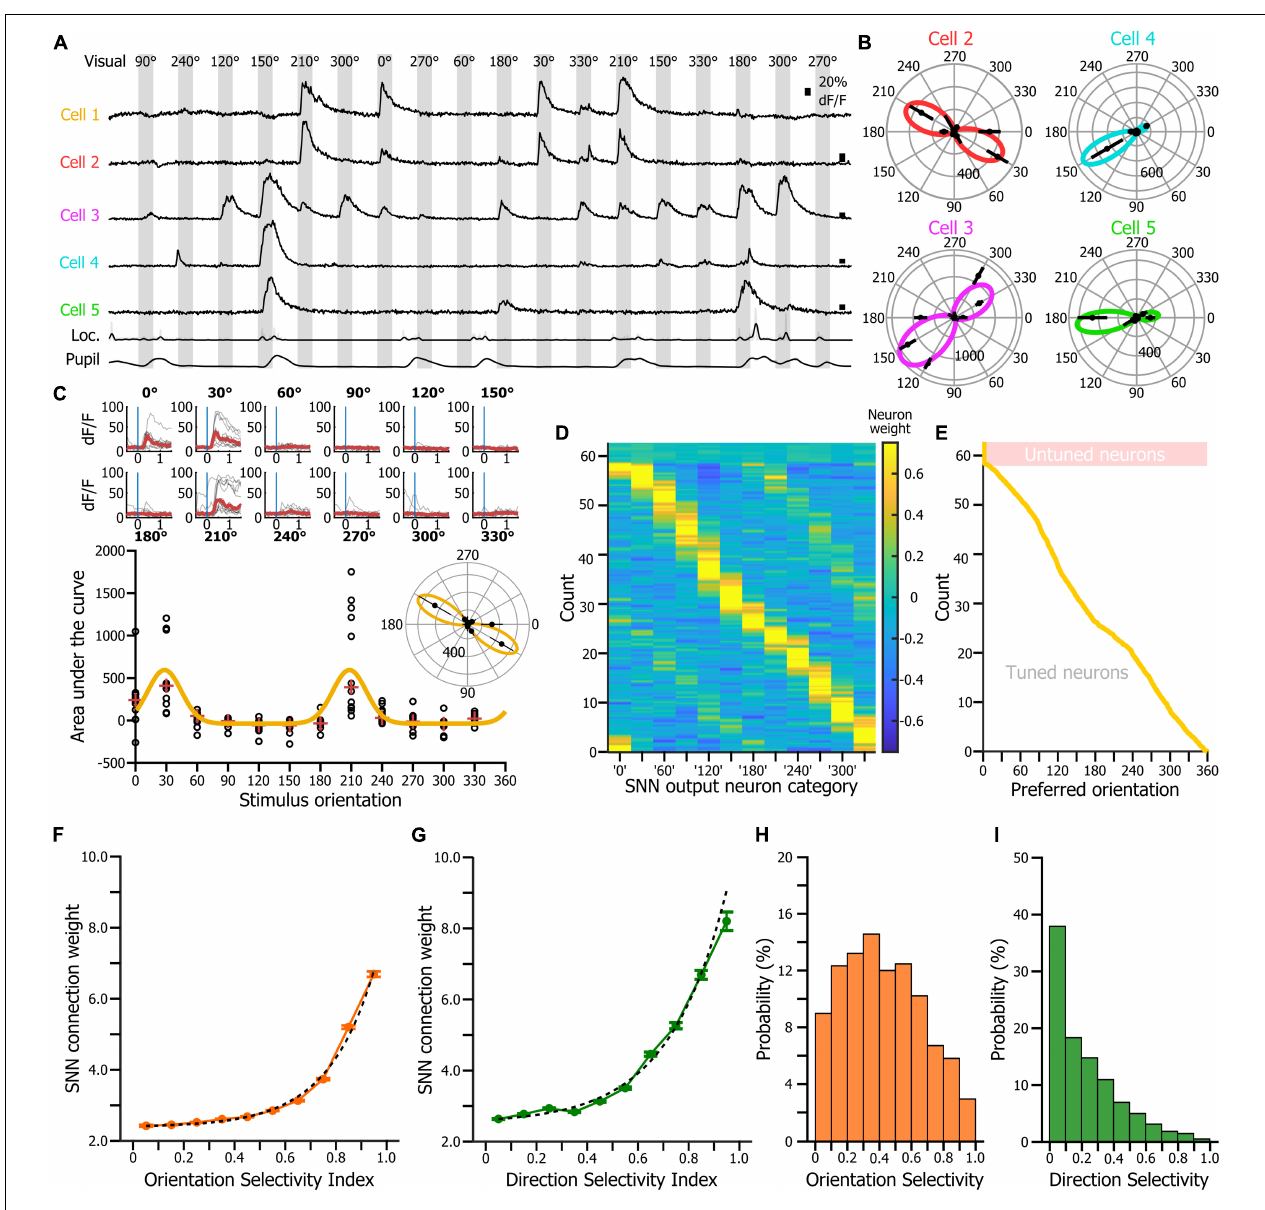
FIGURE 3 | SNN connection weights as a function of the preferred orientation, orientation selectivity and direction selectivity of the input neurons. (A) Activity of the neurons labeled in Figure 1D during an 18-trial segment of the tuning block. (B) Tuning curves of the neurons 2 to 5 shown in panel (A) . Radial axis: area under the curve of the neuronal response. (C) Tuning curve of the cell 1 shown in panel (A) . Top: superimposition of the fractional fluorescence of the neuron for all the trials of the different stimuli of the tuning block. In red is the average of the fractional fluorescence across trials. Bottom: tuning curve (orange line) fitted to the data points (dots). Red crosses indicate the median value across trials. Inset: same tuning curve presented as a polar plot. (D) Connection weights (see color scale) of each input cortical neuron for the 12 SNN outputs ( x -axis). The neurons were ranked by their preferred orientation ( y -axis). Connection weights were normalized using a z -score normalization method. (E) Distribution of the preferred orientations in the input cortical neurons’ population. Presentation matching the presentation shown in panel (D) . (F) Distribution of the input neurons’ connection weights as a function of the V1 neurons’ orientation selectivity indexes. Dotted lines: exponential fit. (G) Distribution of the input neurons’ connection weights as a function of the V1 neurons’ orientation selectivity indexes. (H) Distribution of the orientation selectivity index in the recorded neuronal population. (I) Distribution of the direction selectivity index in the recorded neuronal